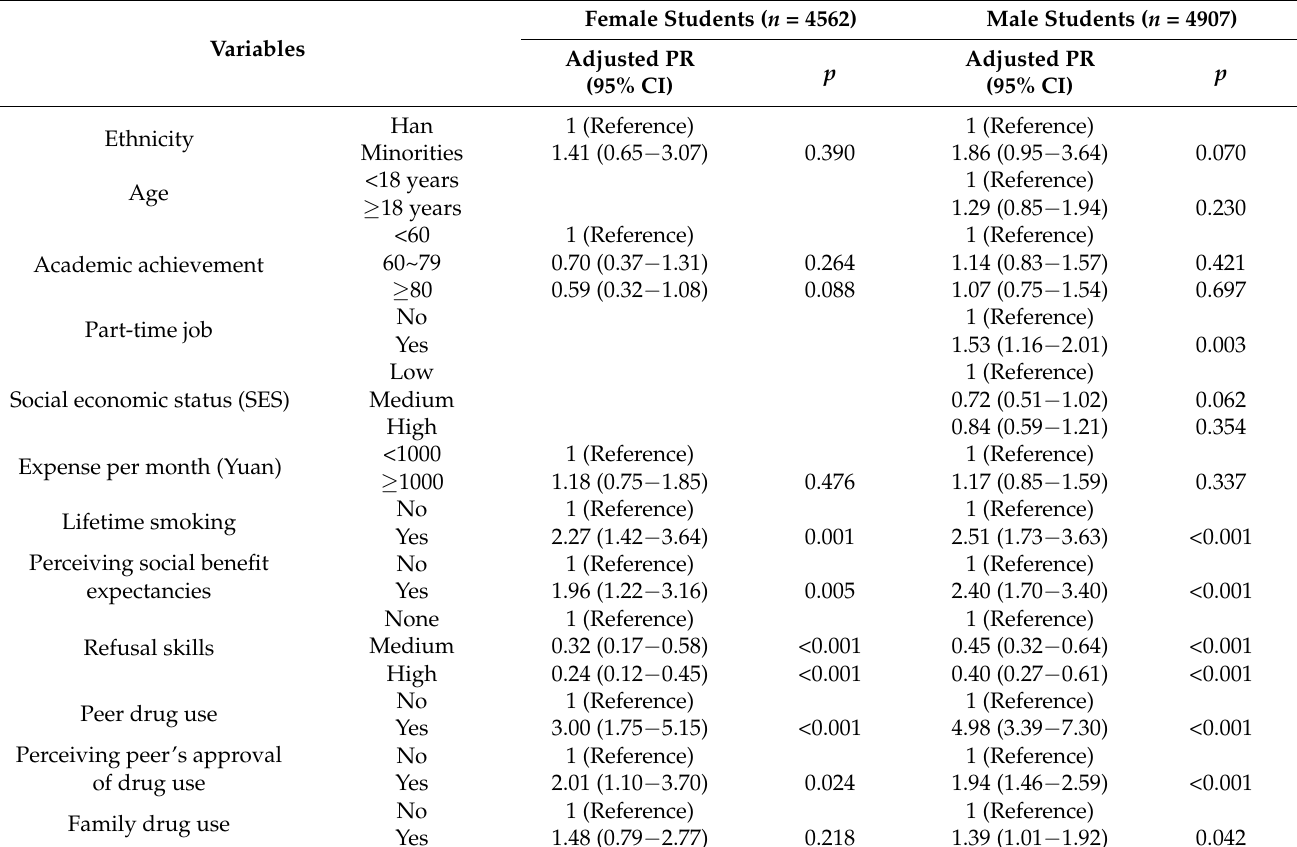
Table 2. Adjusted prevalence ratios (aPR) and 95% confidence intervals (CIs) of lifetime club drug use among female and male